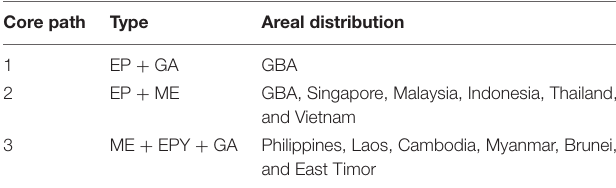
TABLE 5 | Regional distribution of entrepreneurial core elements